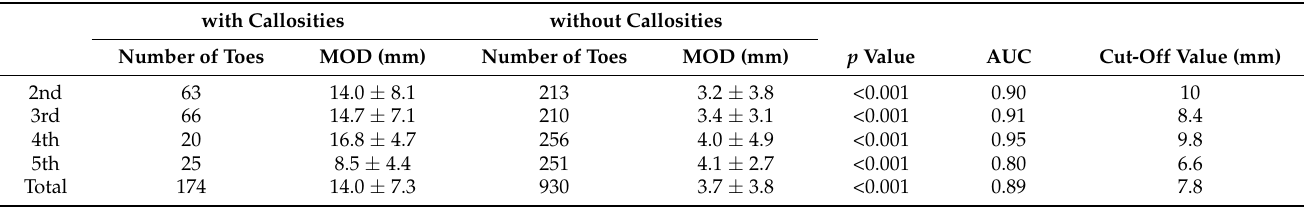
Table 1. The mean MOD of toes with or without callosities.